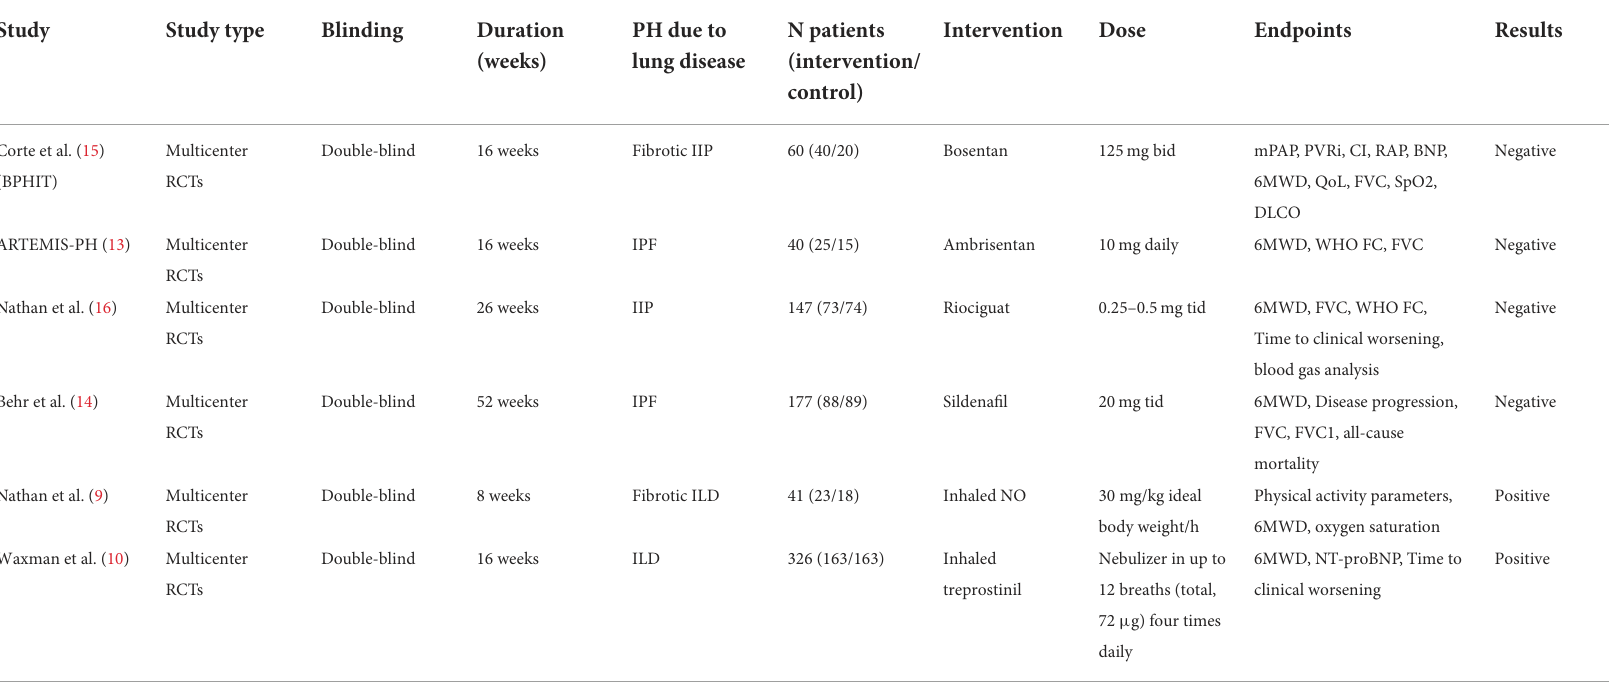
TABLE 1 Characteristics of included